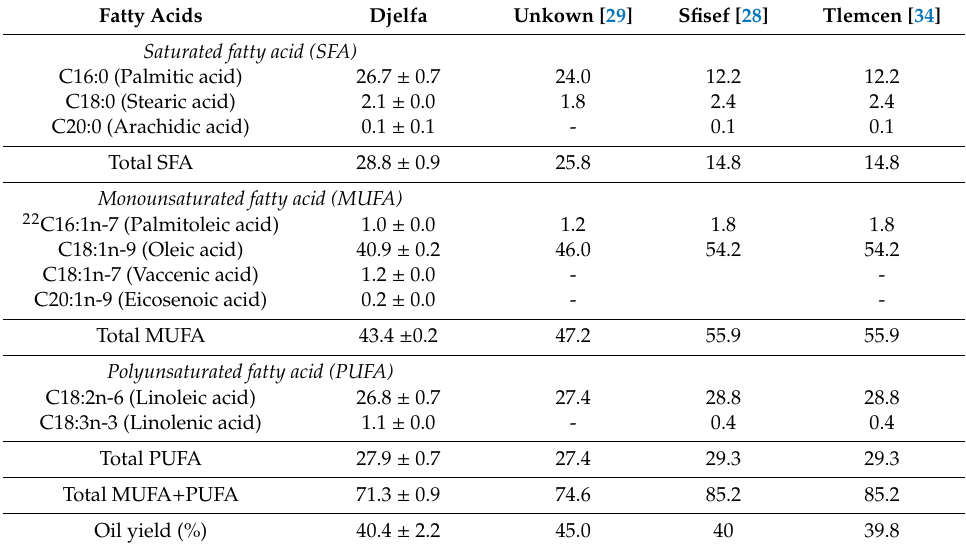
Table 2. Oil content and fatty acid composition (%) of pistachio seed harvested in Djelfa (south of Algeria) in 2016 and results already published on pistachio harvested in di ff erent locations in Algeria. Fatty Acids Djelfa Unkown [29] Sfisef [28] Tlemcen